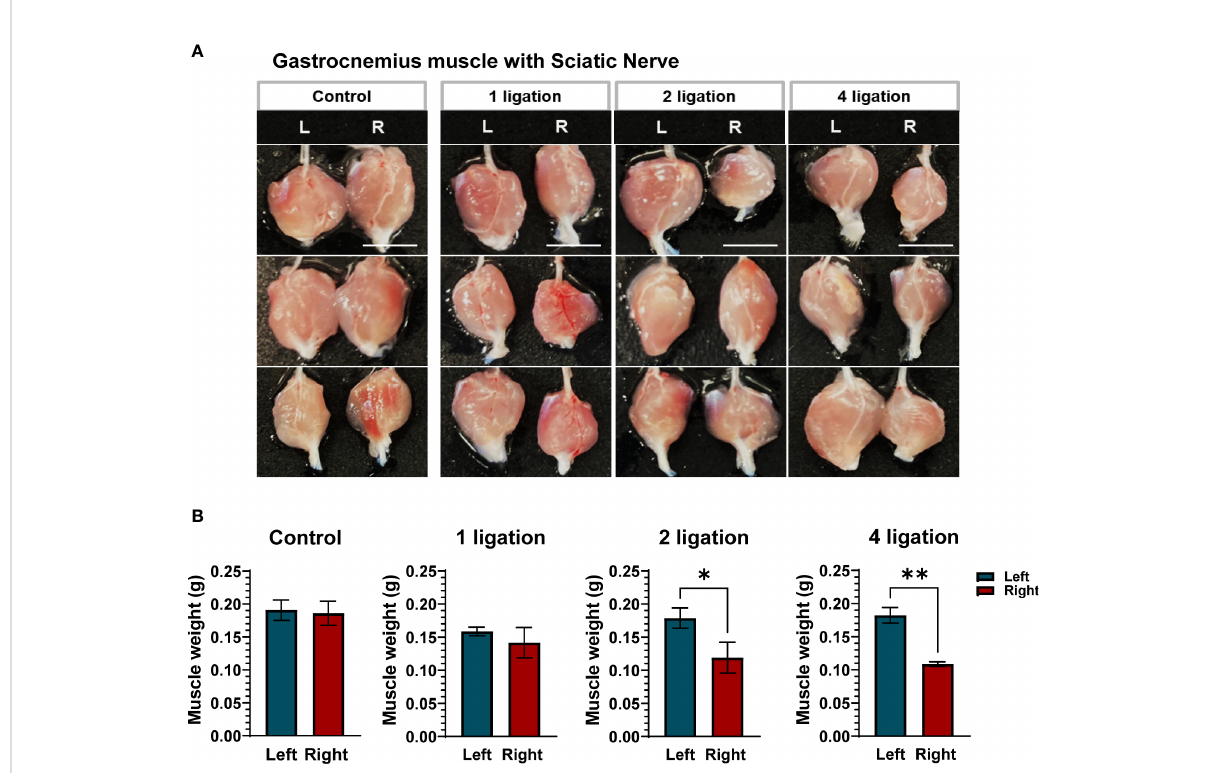
FIGURE 2 Gastrocnemius muscle weight according to the ligations. (A) Gastrocnemius muscles on control, 1, 2 and 4 ligations. Scale bar: 1 cm. (B) The muscle weight (g) was estimated as a ratio to compare the left hindlimb muscle (Blue bar) to the right contralateral site (Red bar) (n = 5 per group). Data are presented as mean ± SEM. Statistical signi fi cance was analyzed using two-tailed Student ’ s t-test, * p < 0.05, ** p <